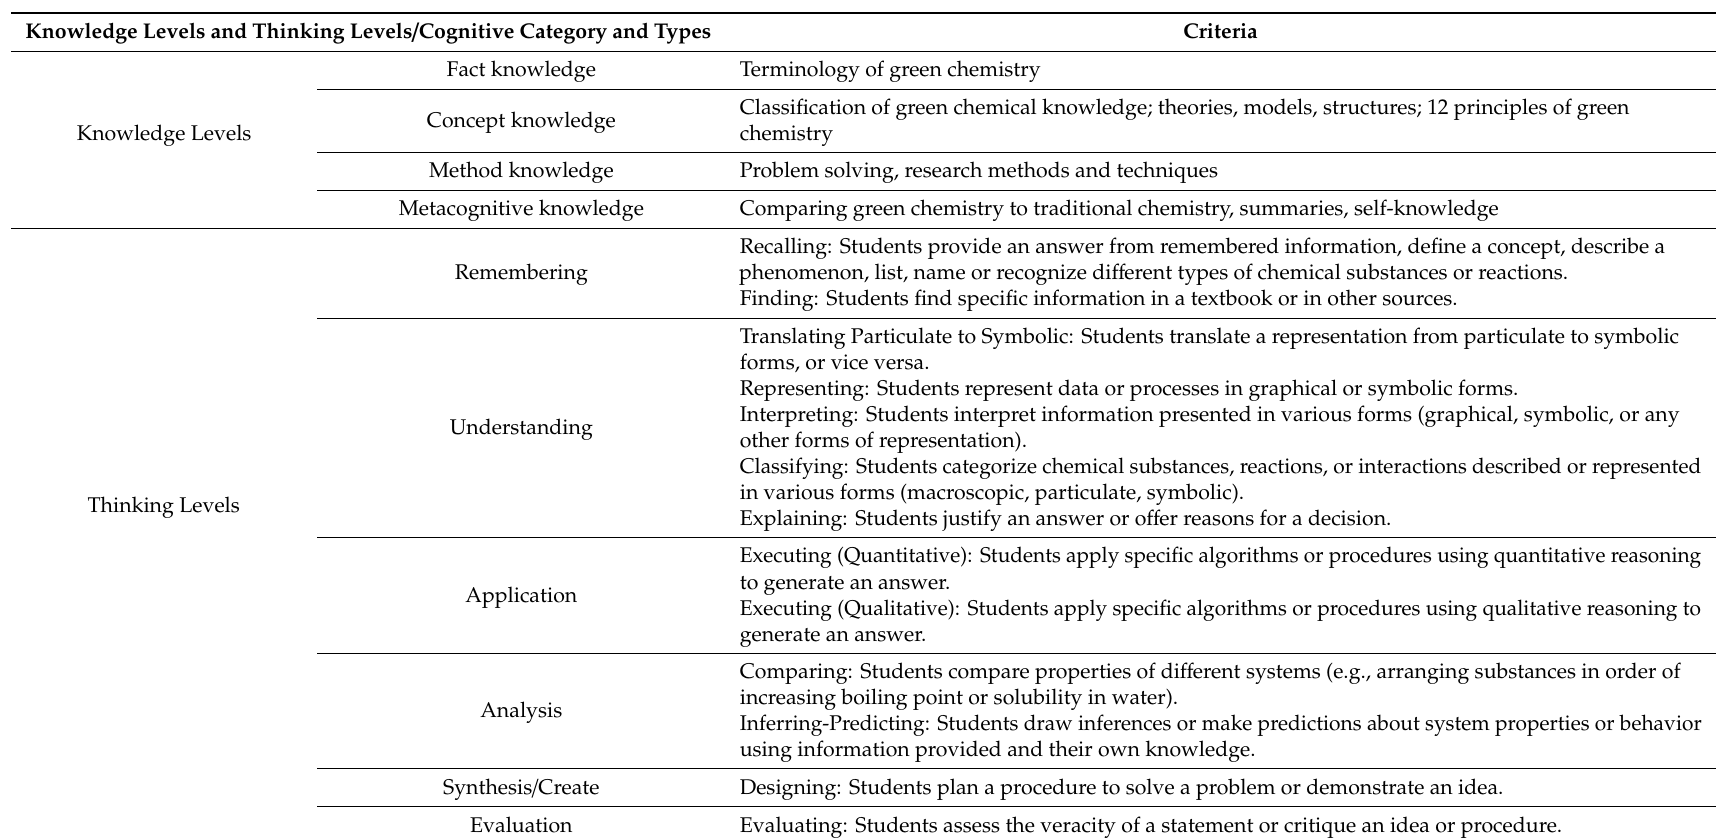
Table 2. The knowledge levels and thinking levels, cognitive categories and types according to Bloom’s revised taxonomy for chemistry [107,108,114,115,122–124]. Knowledge Levels and Thinking Levels / Cognitive Category and